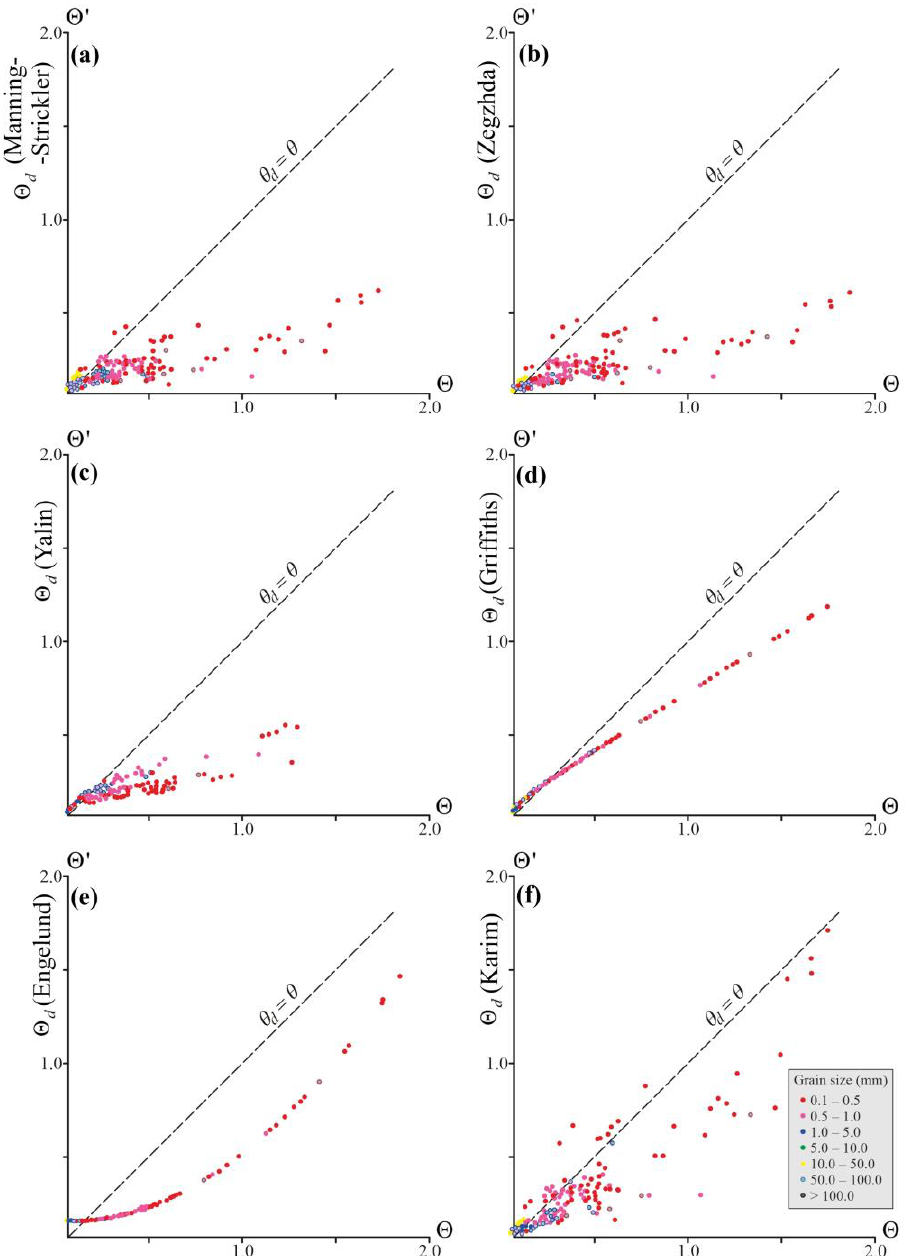
Figure 3. Results of analytical dependence of Θ d = f ( Θ ) graphs, where: ( a )—Manning–Strickler formula; ( b )—Zegzhda formula; ( c )—Yalin formula; ( d )—Griffiths’ formula; ( e )—Engelund formula; ( f )—Karim formula.